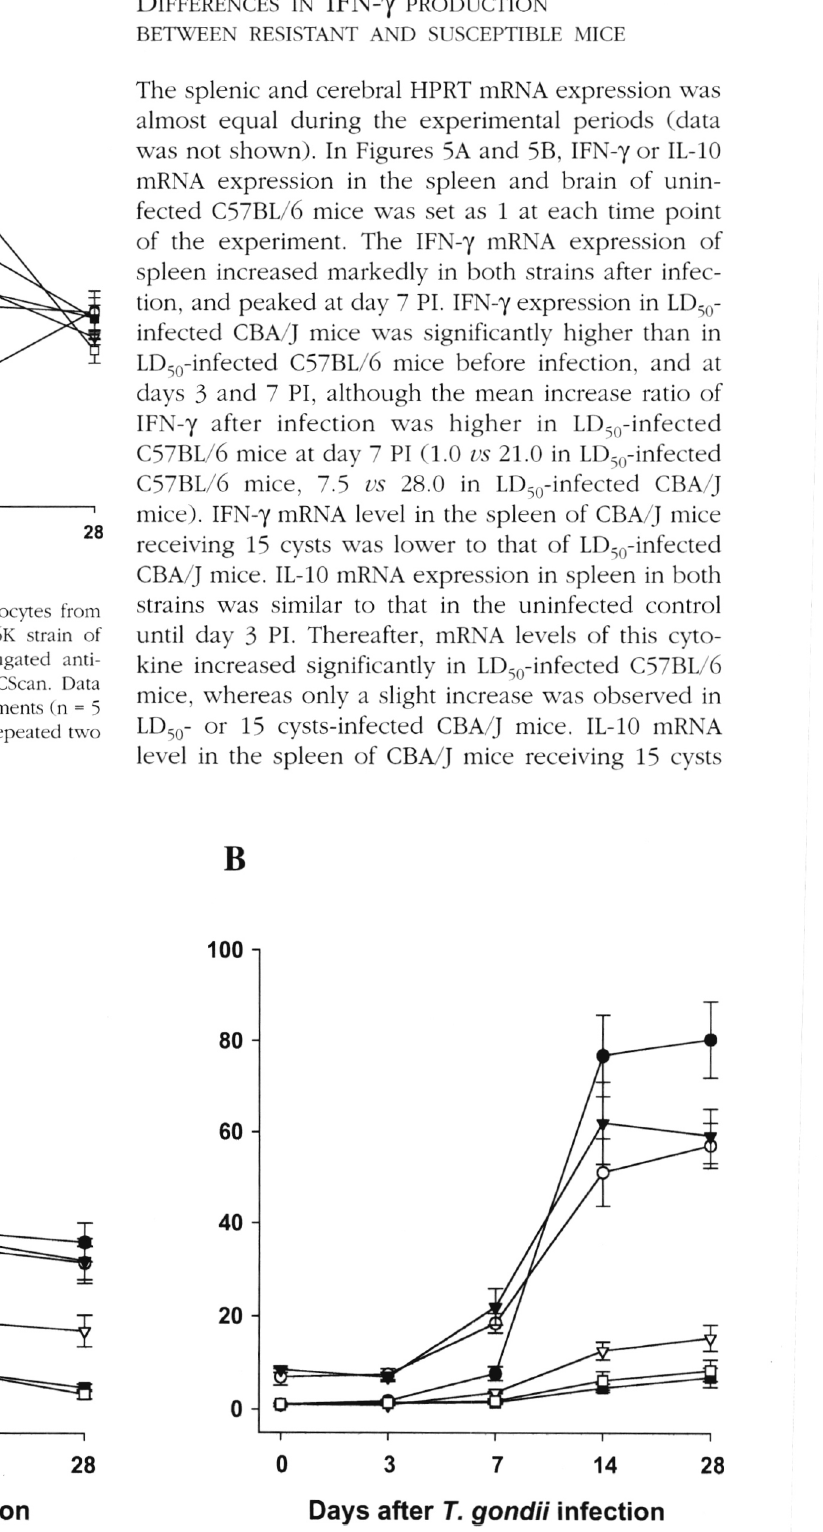
Fig. 5. - Cytokine mRNA levels in spleens (A) and brain (B) from C57BL/6 and CBA/J mice orally infected with the 76K strain of T. gondii. Data are expressed as relative increase in mRNA levels over the spleen or brain of uninfected C57BL/6 mice at each time point. IFN-y or IL-10 mRNA expression in the brain and spleen of uninfected C57BL/6 mice was set as 1 at each time point of the experiment. Data shown are the mean ± SD of one of two separate experiments (n = 5 for each value at all time point). The experiment was repeated two times with essentially similar